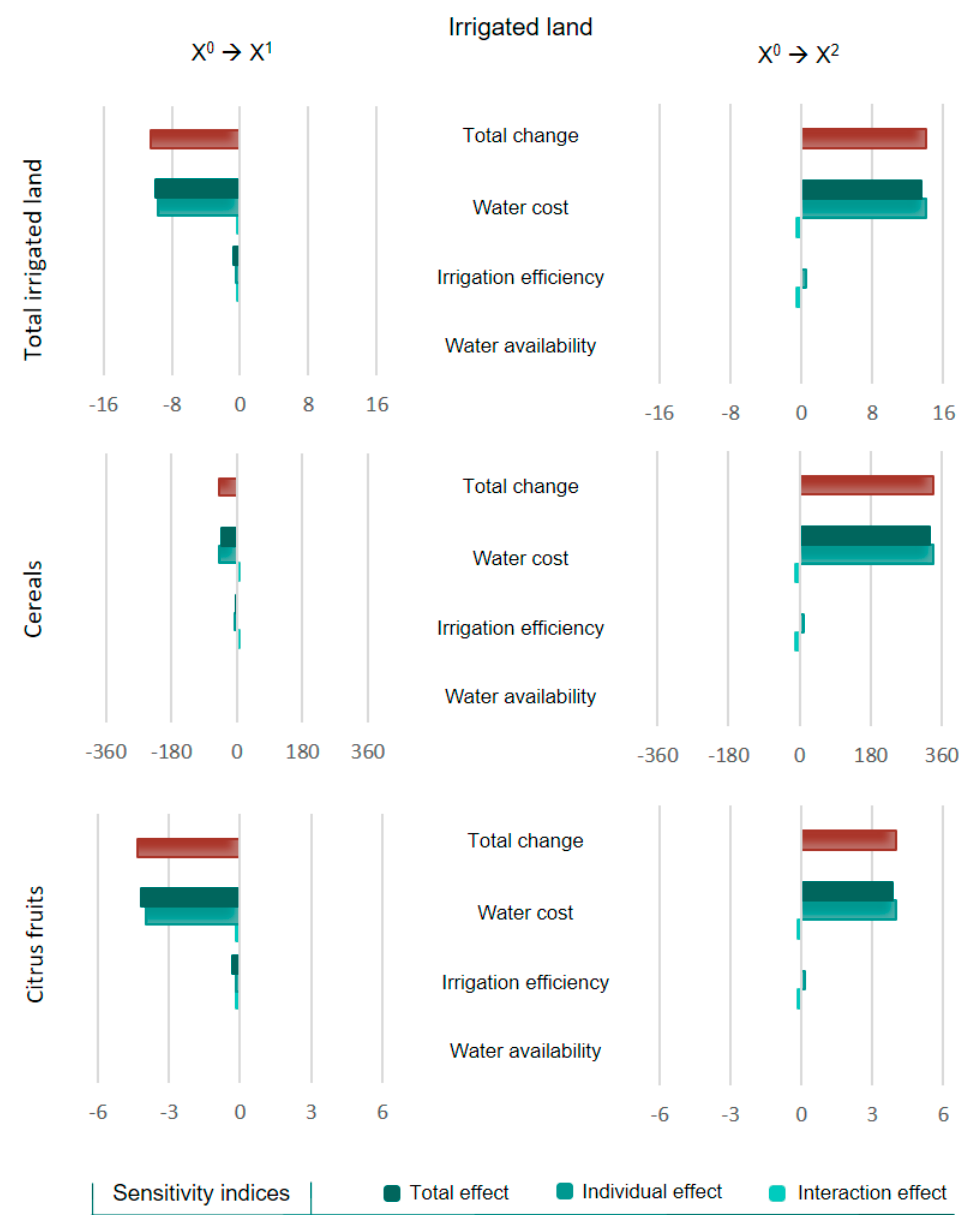
Figure 2. Sensitivity of irrigated agricultural land (total, cereals, citrus fruits) to scenario drivers when shifting from the reference to the worst-case scenario ( left ) and to the best-case scenario ( right ). The total change in irrigated land is decomposed into changes due to total, individual and interaction effects of each driver. The results are presented as % change from the reference scenario.